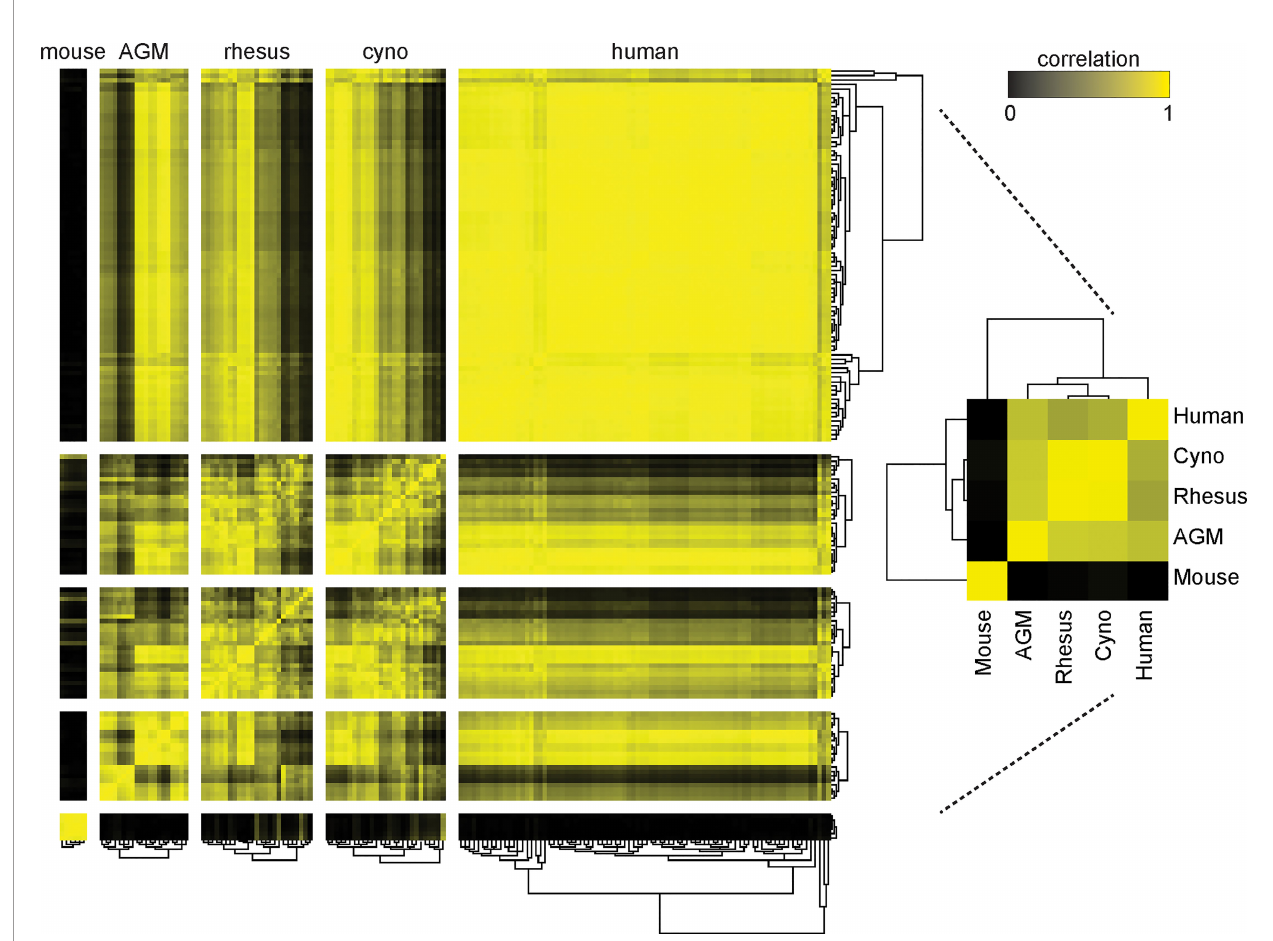
FIGURE 3 | Clustering of species by their cell type frequencies recapitulates the evolutionary tree. The average frequencies of 10 cell types (Neutrophils, Basophils, B Cells, CD8+ T Cells, CD4+ T Cells, CD4+/CD8+ T Cells, pDCs, NK Cells, Classical Monocytes and Nonclassical Monocytes) in each species was calculated and then clustered according to their pairwise correlations between species (right). This major clustering order was preserved in the larger heatmap (left), in which each individual donor is displayed and clustered by their individual cell type frequencies. Metric: PearsonCorrelation[freqs_species_1, freqs_species_2] 2 ; distance function: Euclidean; linkage: